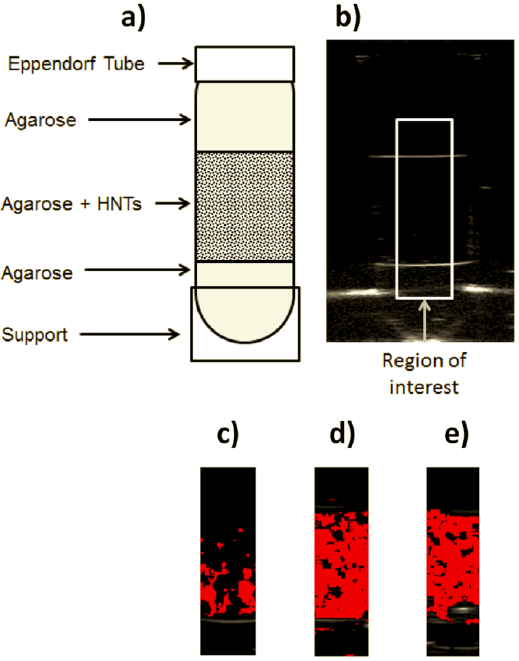
Figure 4. Automatic detection experiments: ( a ) scheme of the adopted phantom; ( b ) B-mode image of a control phantom (HNT concentration = 0 part/mL) with indication of the chosen region of interest (ROI); ( c – e ) sample images of the analyzed ROIs with the superimposed color maps for automatic HNT detection at the following concentrations: 16.5 × 10 10 part/mL ( c ), 33 × 10 10 part/mL ( d ), 66 × 10 10 part/mL ( e ).